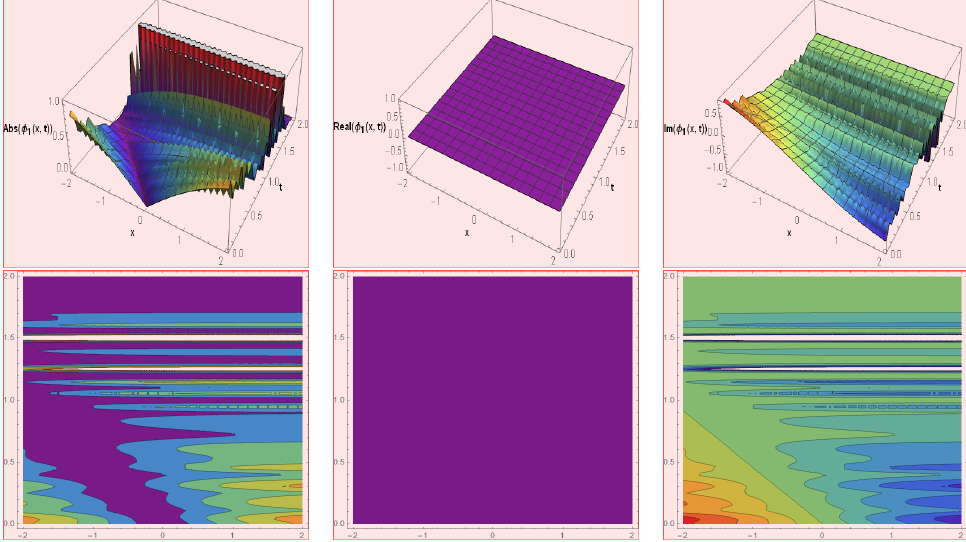
Figure 1. The absolute, real, and imaginary behavior in the shape of 3D and their corresponding contour plots are dispatched for φ 1 ( x , t ) .